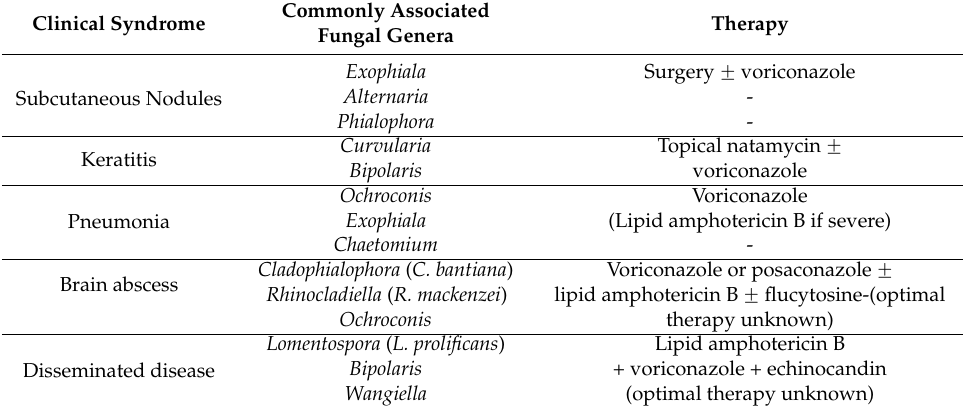
Table 1. Clinical syndromes associated with phaeohyphomycosis and suggested